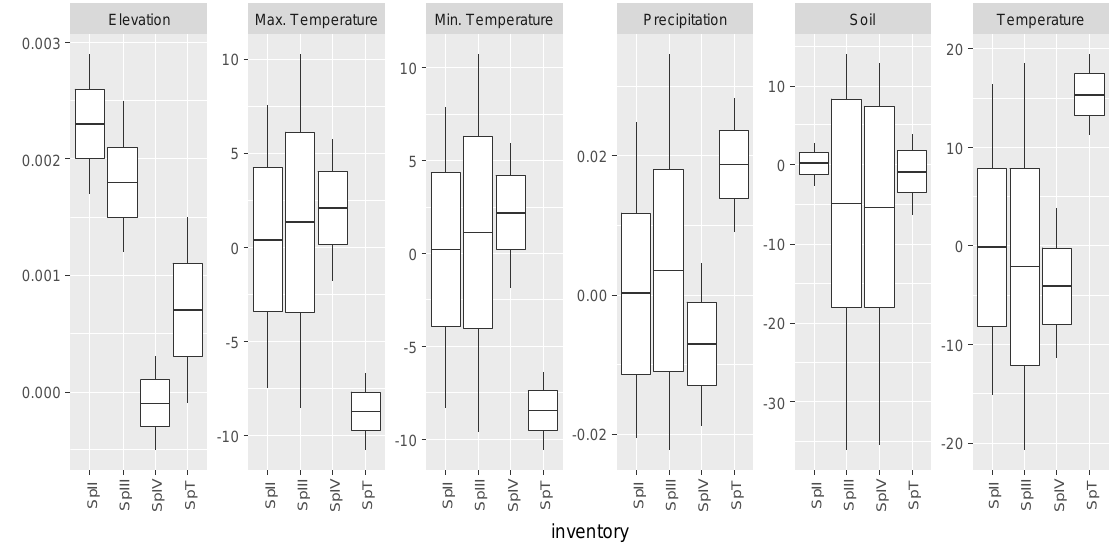
Figure 6. Boxplot diagram for posterior estimates of the covariates for C. sativa models: Spatial model II inventory (SpII); Spatial model III inventory (SpIII); Spatial model IV inventory (SpIV); Spatio-temporal model (SpT).